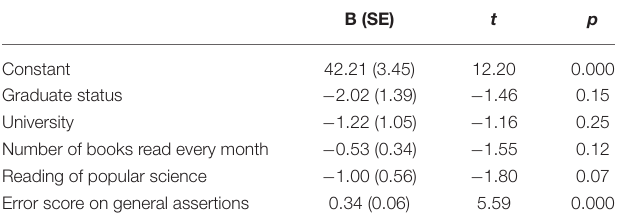
TABLE 3 | Predictors of neuromyths error